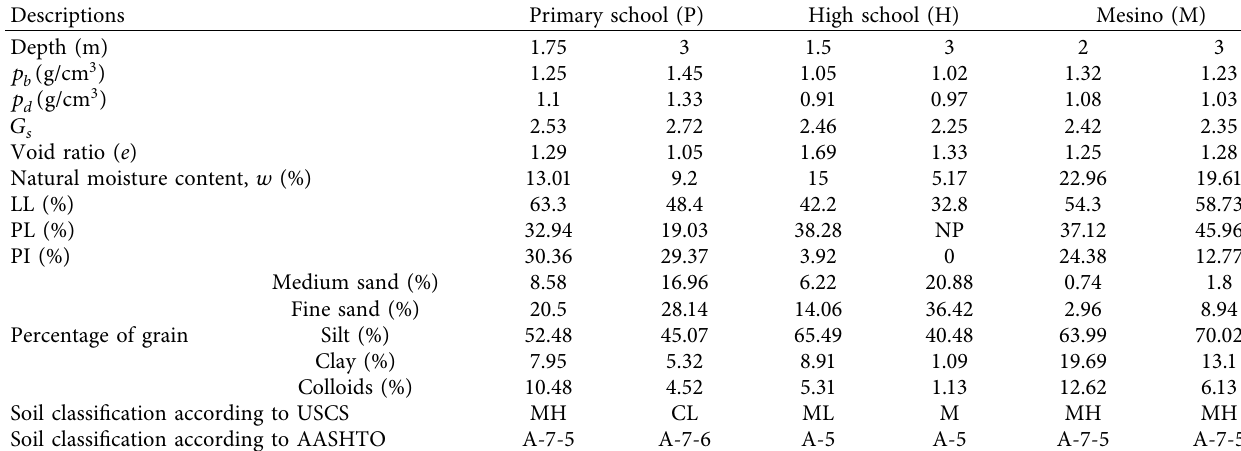
Table 3: Summary of index properties’ test results.